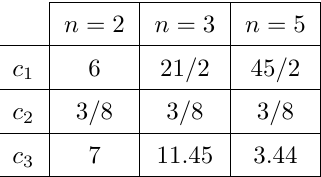
Table 7. Numerical values of coe(cid:14)cients c (cid:12) ( n ) for Ans(cid:127)atz II